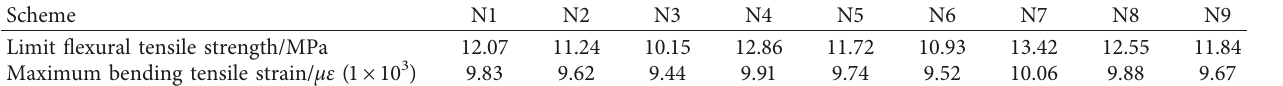
Table 9: Trabecular bending test results.